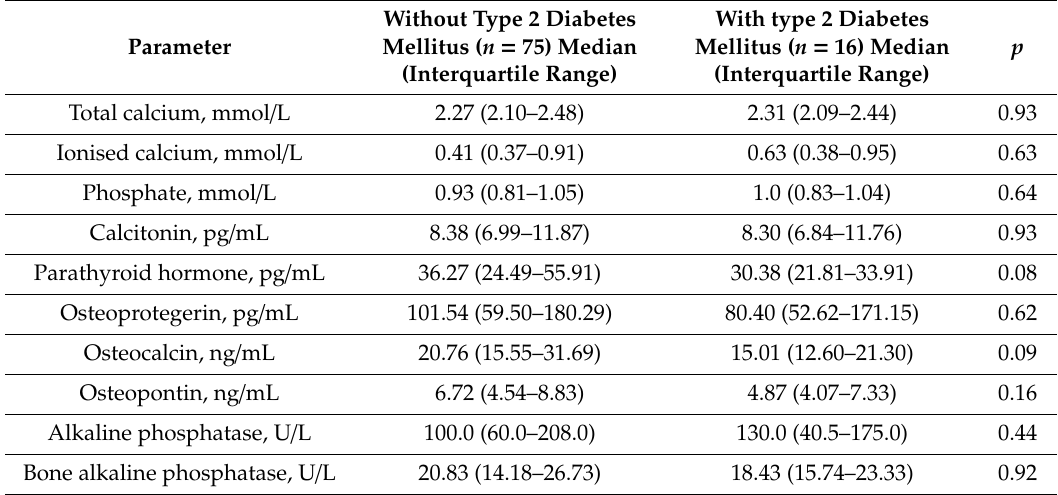
Table 6. Parameters of mineral homeostasis in relation to the patients with type 2 diabetes